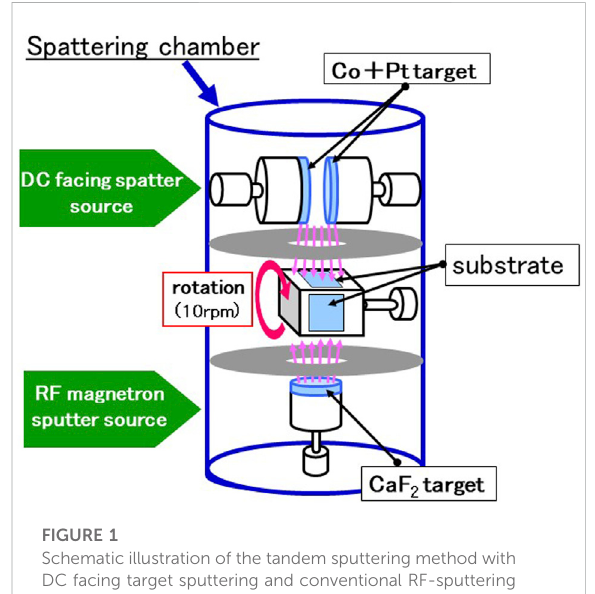
FIGURE 1 Schematic illustration of the tandem sputtering method with DC facing target sputtering and conventional RF-sputtering sources.(Co.+Pt)targetwasplacedontheDCsputtersource,and CaF 2 the target was placed on the RF sputter source. The substrateholderrotatesalternatelytowardstheDC-sputteringand RF-sputtering sources.